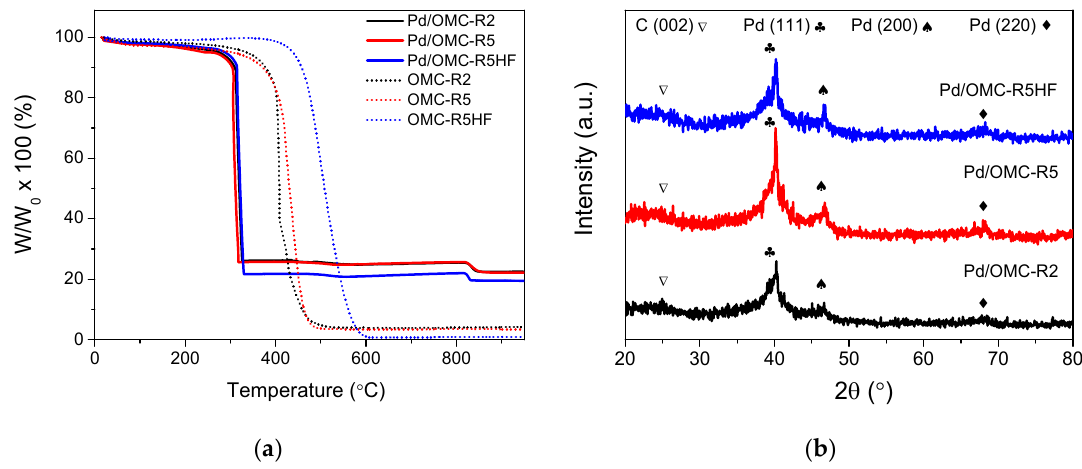
Figure 3. ( a ) TGA profiles of Pd/OMC and OMC. ( b ) XRD patterns of Pd/OMC catalysts. The structure of Pd / C catalysts was studied by XRD (Figure 3b). Three representative peaks appeared at 2 θ = 39.4, 45.6 and 67.4 in all the electrocatalyst patterns, which can be ascribed to (111), (200) and (220) planes of Pd, respectively. These results indicate that Pd was deposited with an fcc structure. Pd crystallite sizes (Table 3) were obtained by Scherrer’s equation on the (220) contribution assuming K = 0.89 [27]. Similar sizes were obtained for all the catalysts, with a value of around 3–4 nm. TEM micrographs together with particle size distributions of Pd/OMC catalysts are given in Figure 4. In general, uniform dispersion of Pd nanoparticles on the OMC materials was obtained.